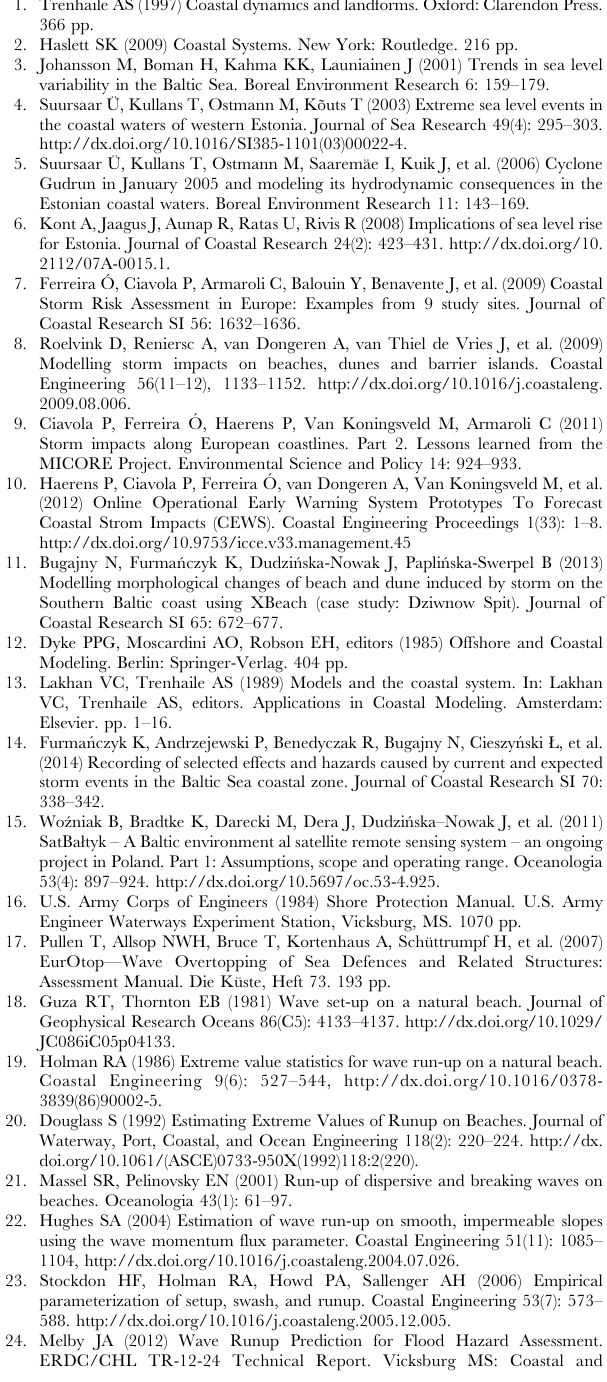
Table S1B. Extreme wave run-ups and wave